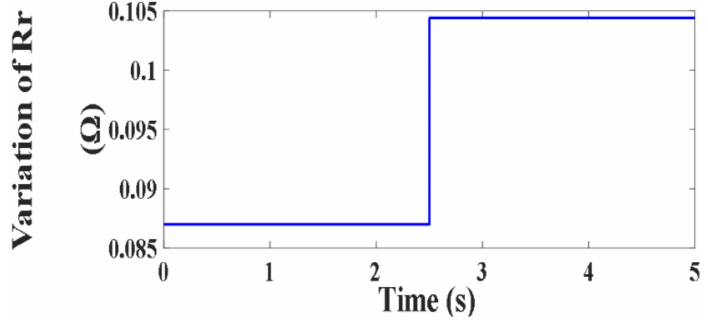
Figure 144. Variation of R r ( Ω ).